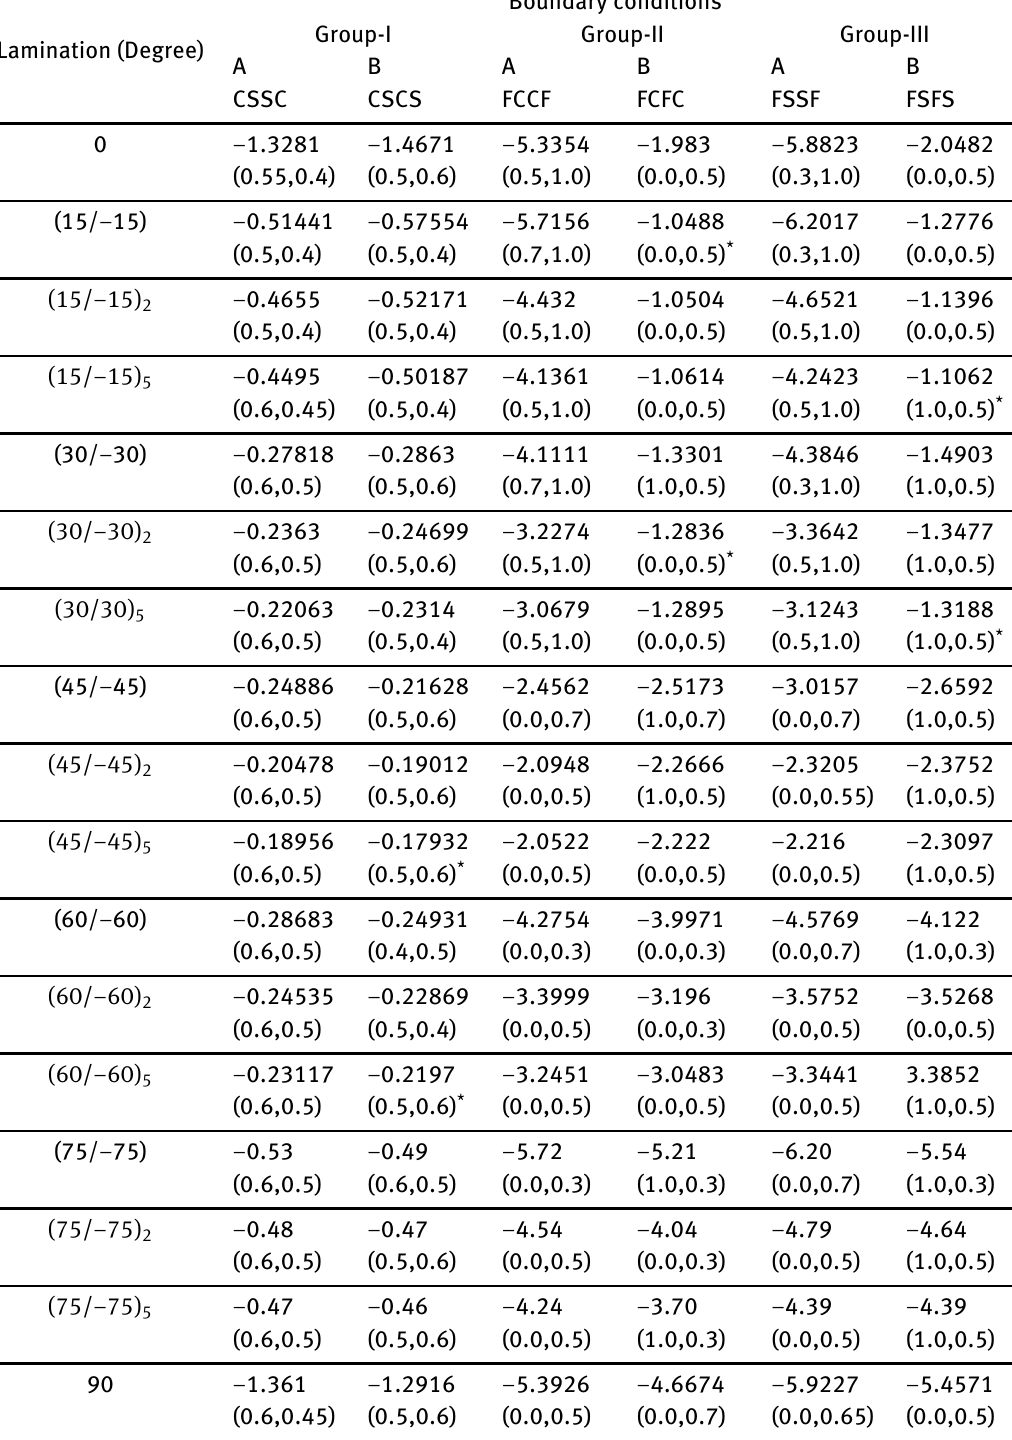
Table 3: Values of maximum non-dimensional downward deflections (− w ) x 10 4 for different antisymmetric angle ply lamination and boundary conditions of stiffened composite hypar shell with